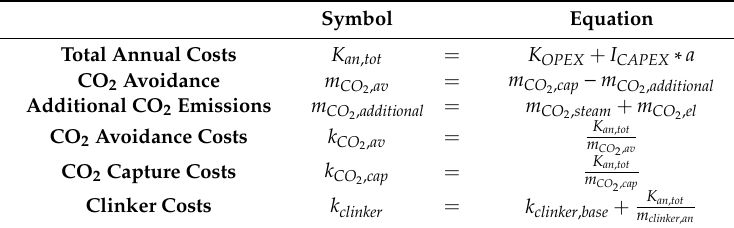
Table 3. Annual costs, CO 2 avoidance, CO 2 avoidance costs, clinker